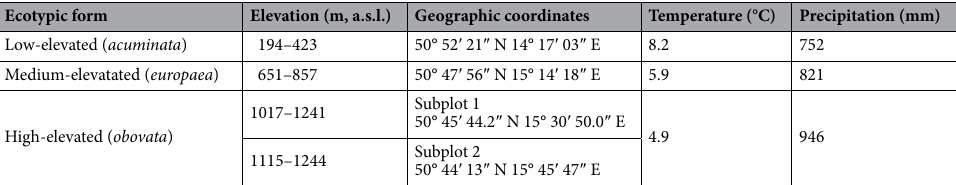
Table 1. Norway spruce ecotypes sampling locations and their climatological data. Average annual air temperature (T), Geographic coordinates are geometrically centered. Climatic values were long-term average measurements 52